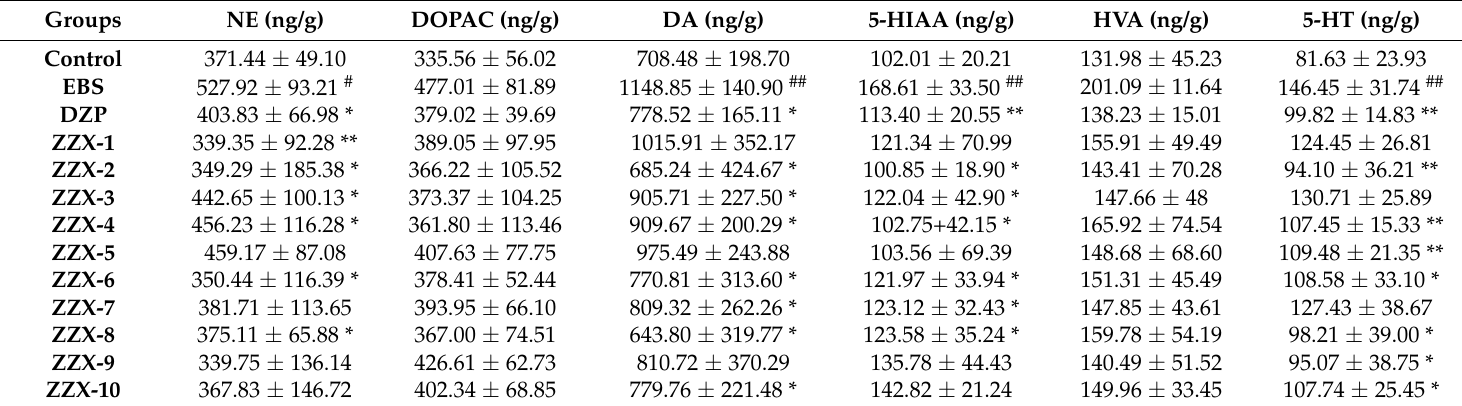
Table 5. Effect of ZZX on the monoamines neurotransmitters and their metabolites in the whole cerebral cortex of rats.